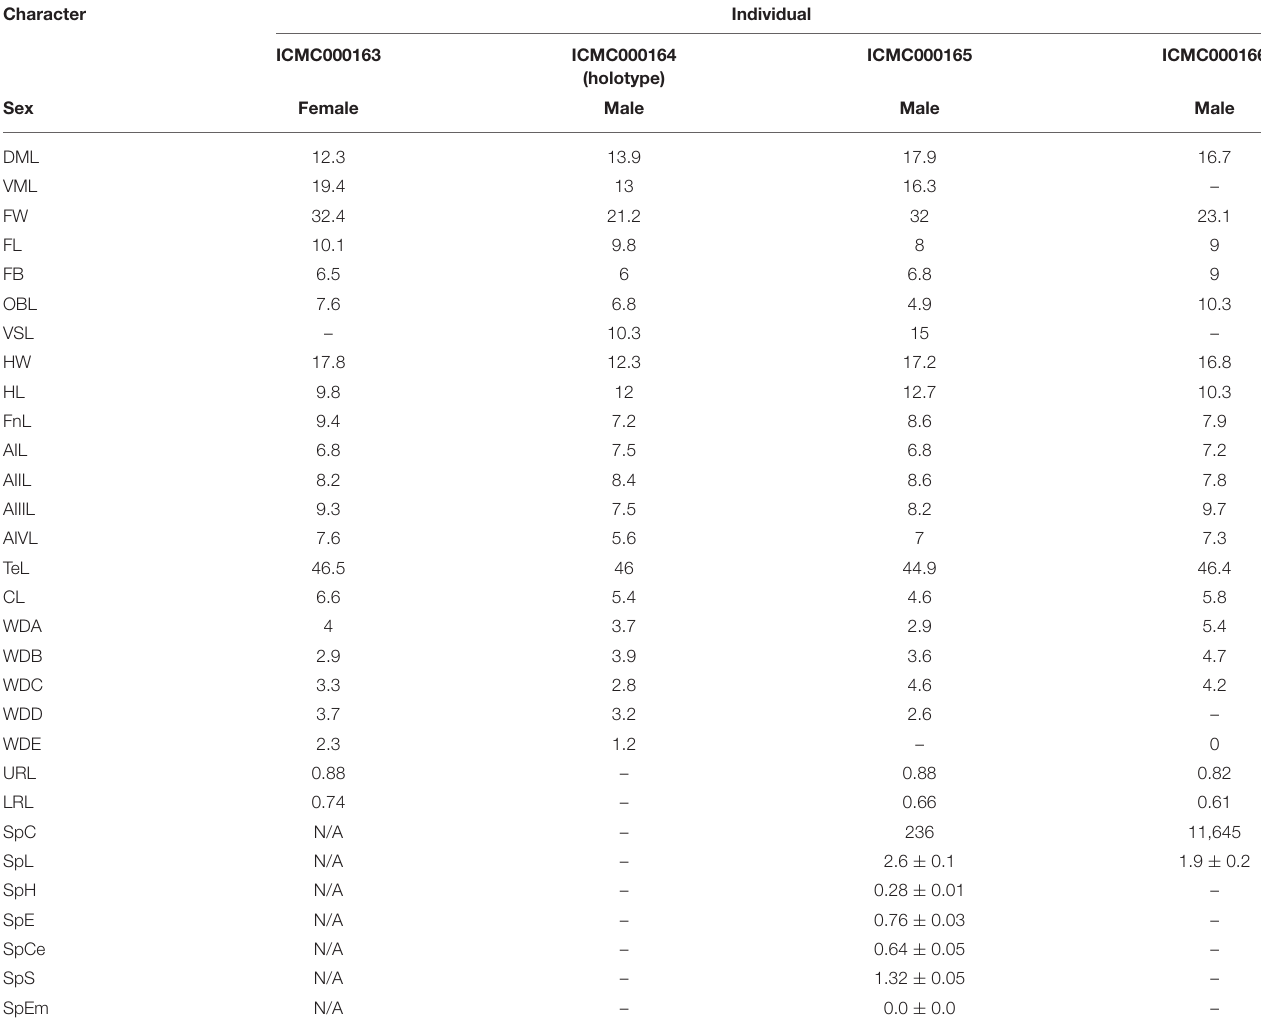
TABLE 5 | Measurements (in mm) of the type material of Stoloteuthis cthulhui sp. nov .